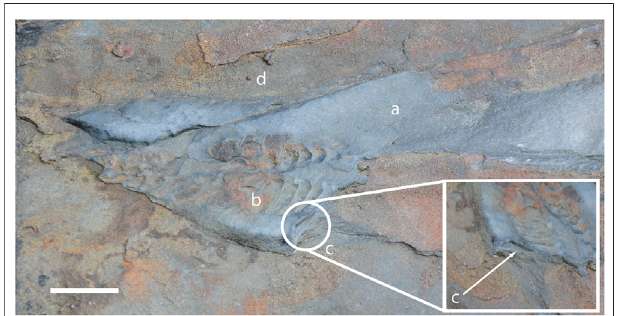
FIGURE 8 | Charniodiscus sp. from Spaniard ’ s bay, Newfoundland. (A) Overlying siltstone. (B) collapsed sub-conical frond preserved in sandstone. (C) cross section view. (D) underlying siltstone. Scale bar 1 cm. Field photography. Not